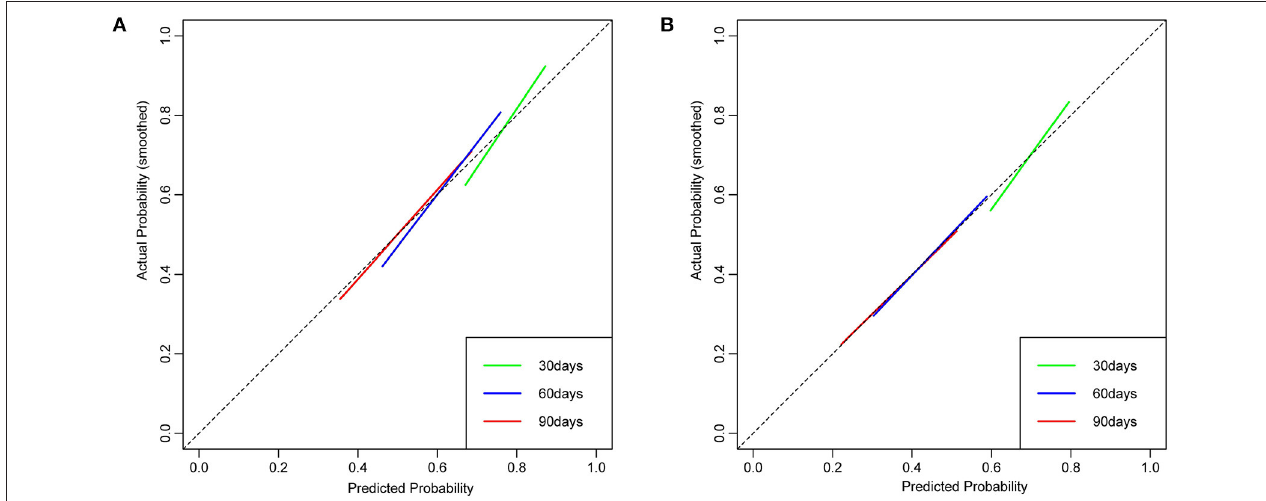
FIGURE 3 | The calibration curve of nomogram at 30, 60, and 90 days for the derivation cohort (A) and the temporal validation cohort (B) . Dashed lines along the 45-degree line through the point of origin represent the perfect calibration models in which the predicted probabilities are identical to the actual